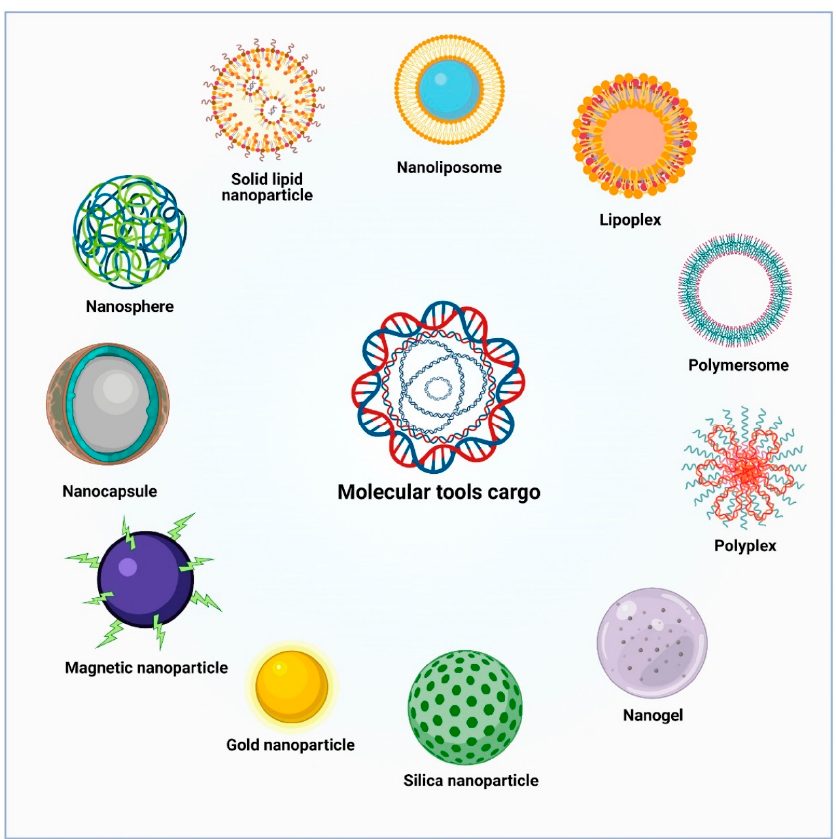
Figure 4. The scheme shows types and morphologies of the NP systems used for treating polyQ SCA diseases.